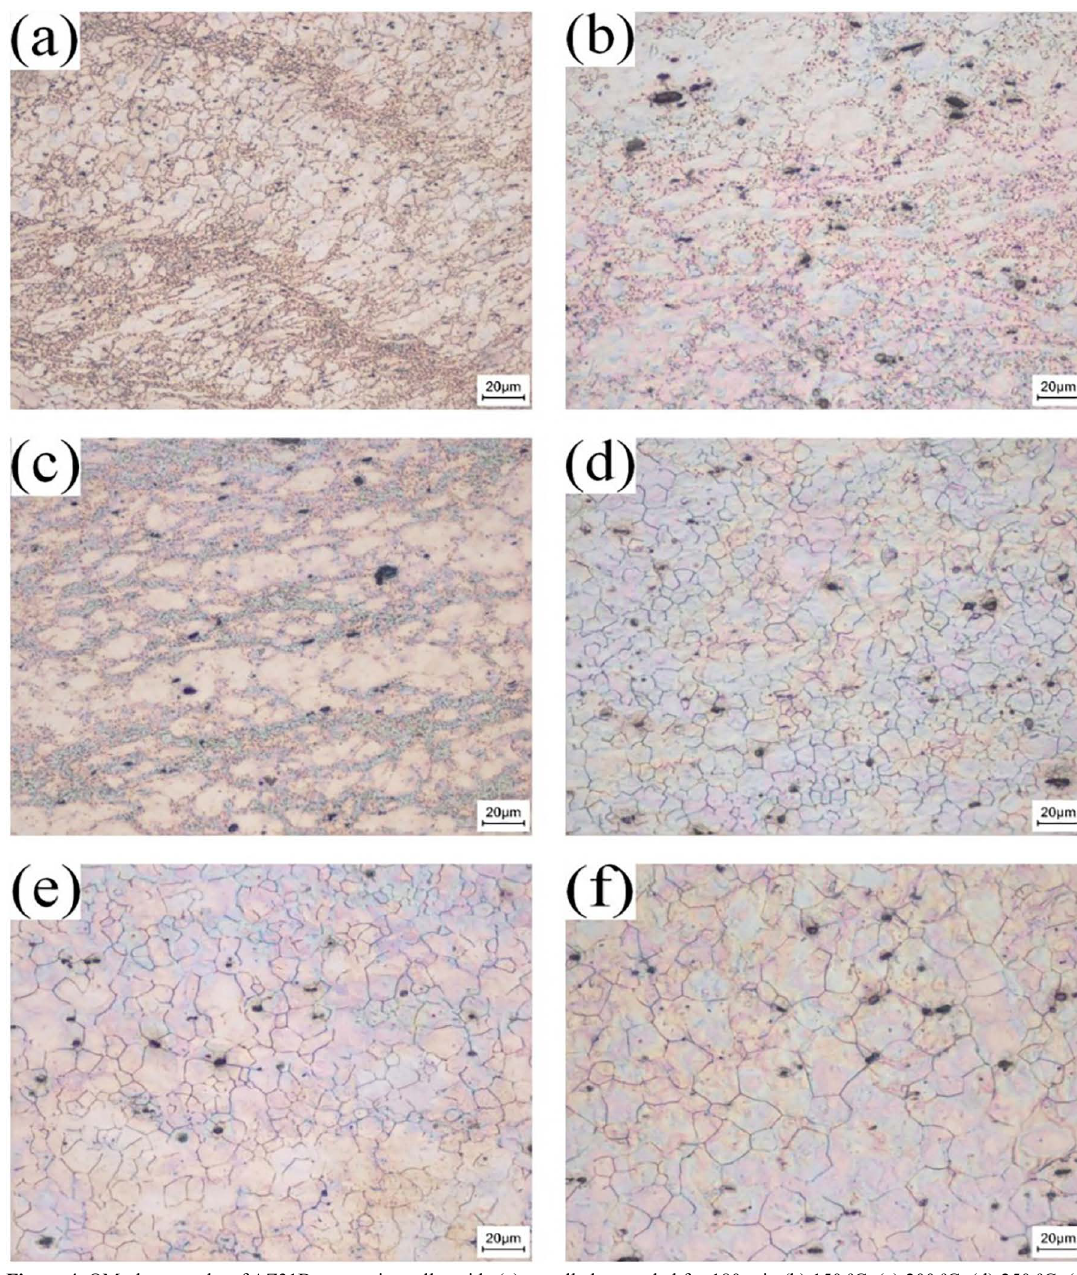
Figure 4. OM photographs of AZ31B magnesium alloy side (a) as-rolled, annealed for 180 min (b) 150 ºC, (c) 200 ºC, (d) 250 ºC, (e) 300 ºC, (f) 400 Table 2. Widths of the interfacial transition zone under different annealing conditions.